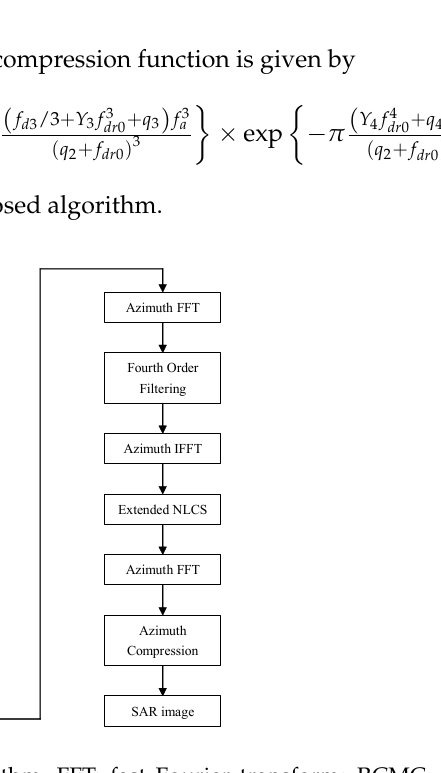
Figure 3. Doppler spectra of seven simulated targets before and after extended nonlinear chirp scaling (NLCS). ( a ) before NLCS; ( b ) after NLCS.